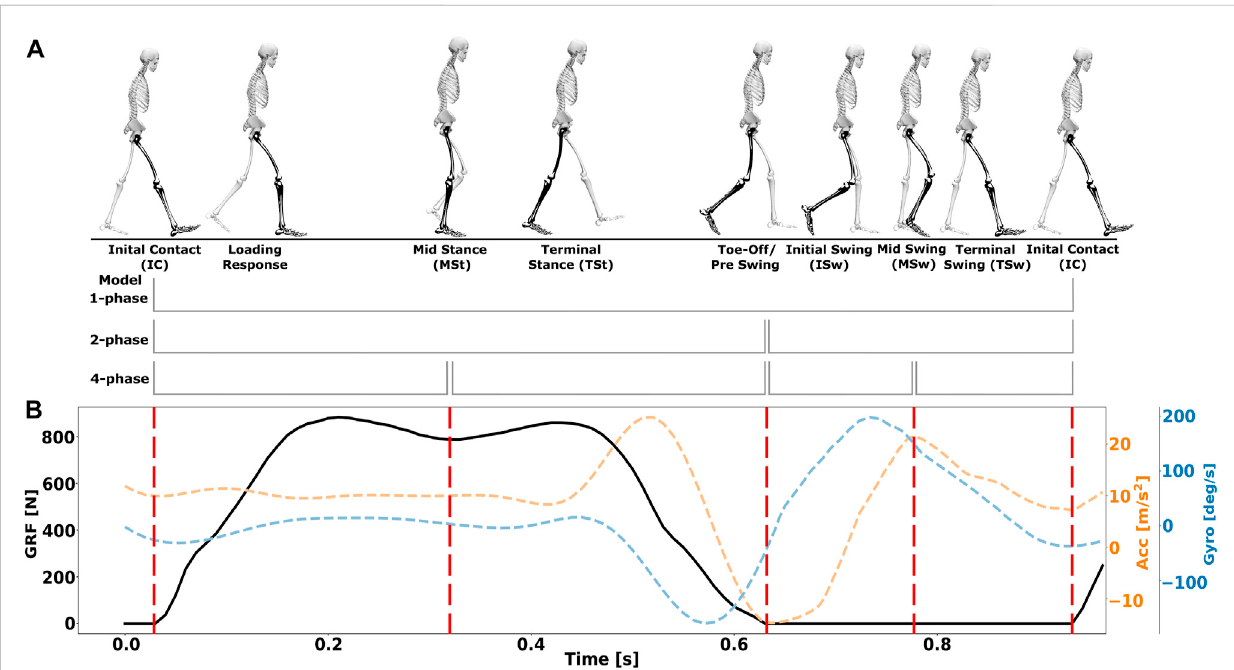
FIGURE 1 Illustrations of human gait phases. (A) Gait cycle division into 1,2,4-phase models. Adapted from (Perry and Bun fi eld, 2010). (B) Visualisation of the four gait events IC, MSt, TO, and MSw aligned with ground reaction force (GRF) data and synthesised accelerometer and gyroscopedata of hemiparentic patients from our co-simulation